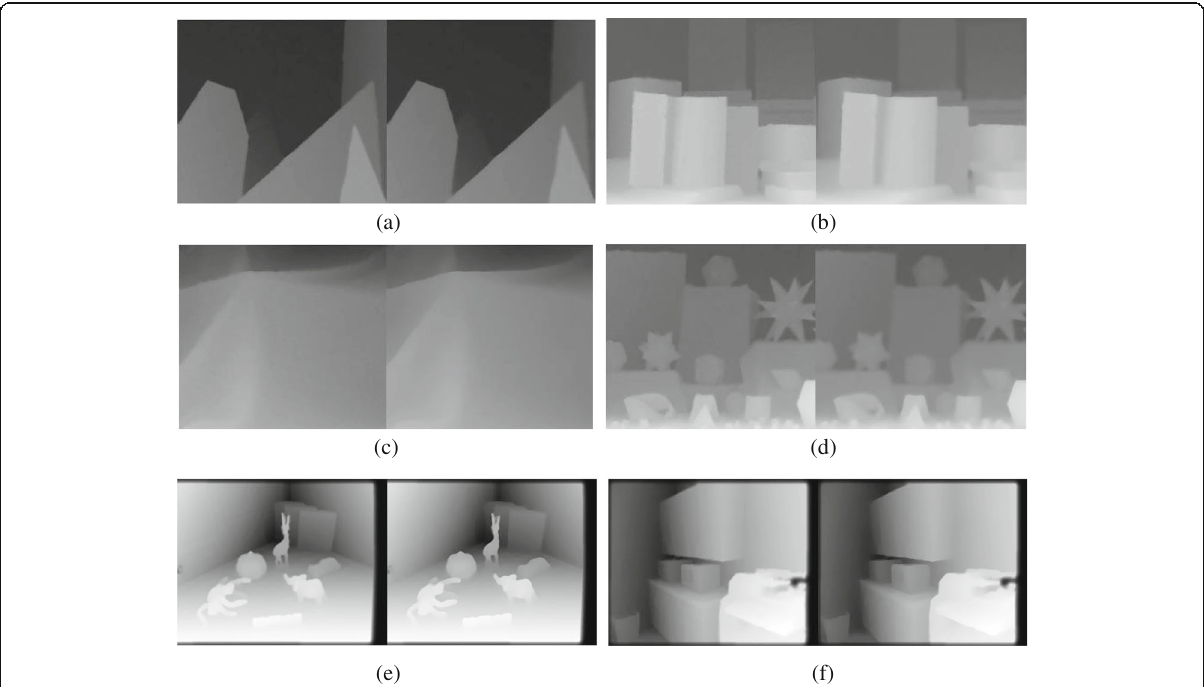
Fig. 8 Four depth map results obtained by the AMF ( left side ) and by the AMF and the RGR ( right side ): a Art , b Books , c Doily , d Moebius , e RGBD_1 , and f RGBD_2